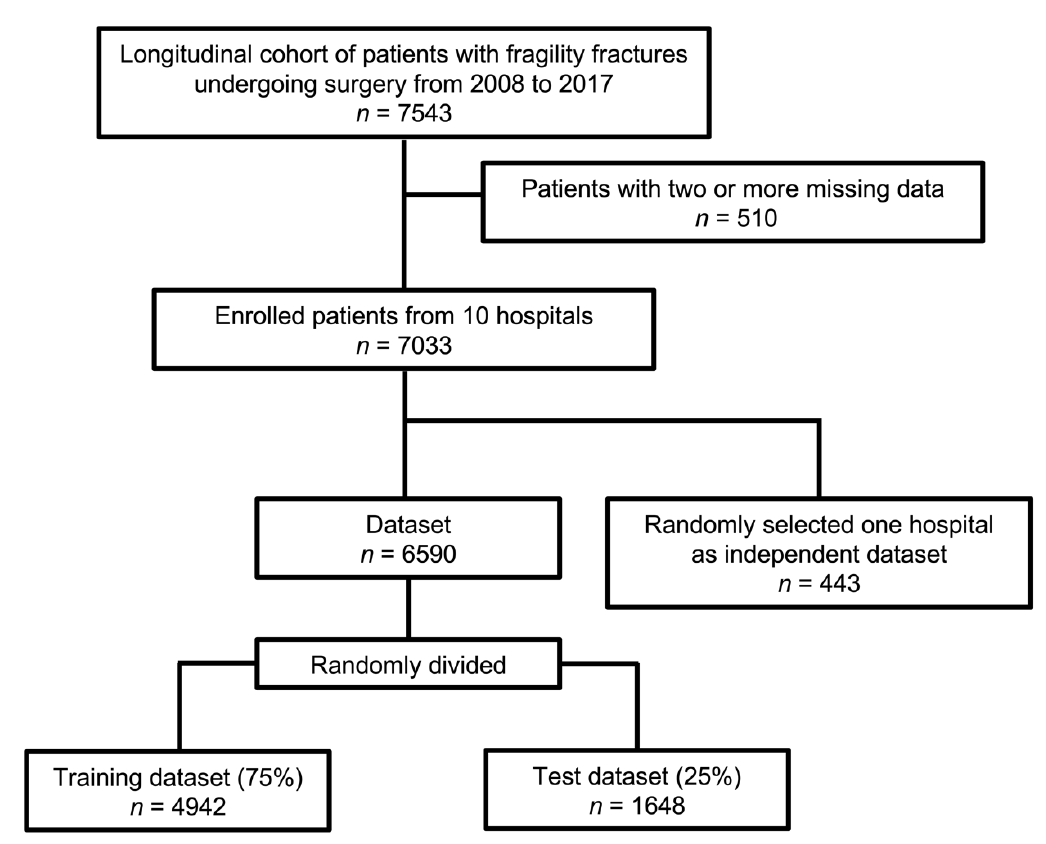
Figure 1. Study Figure 1. Study design.